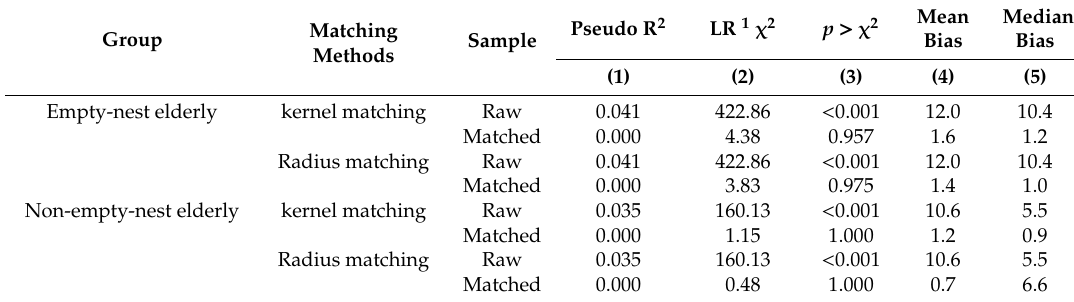
Table 3. Test of the overall balance from kernel and radius matching.